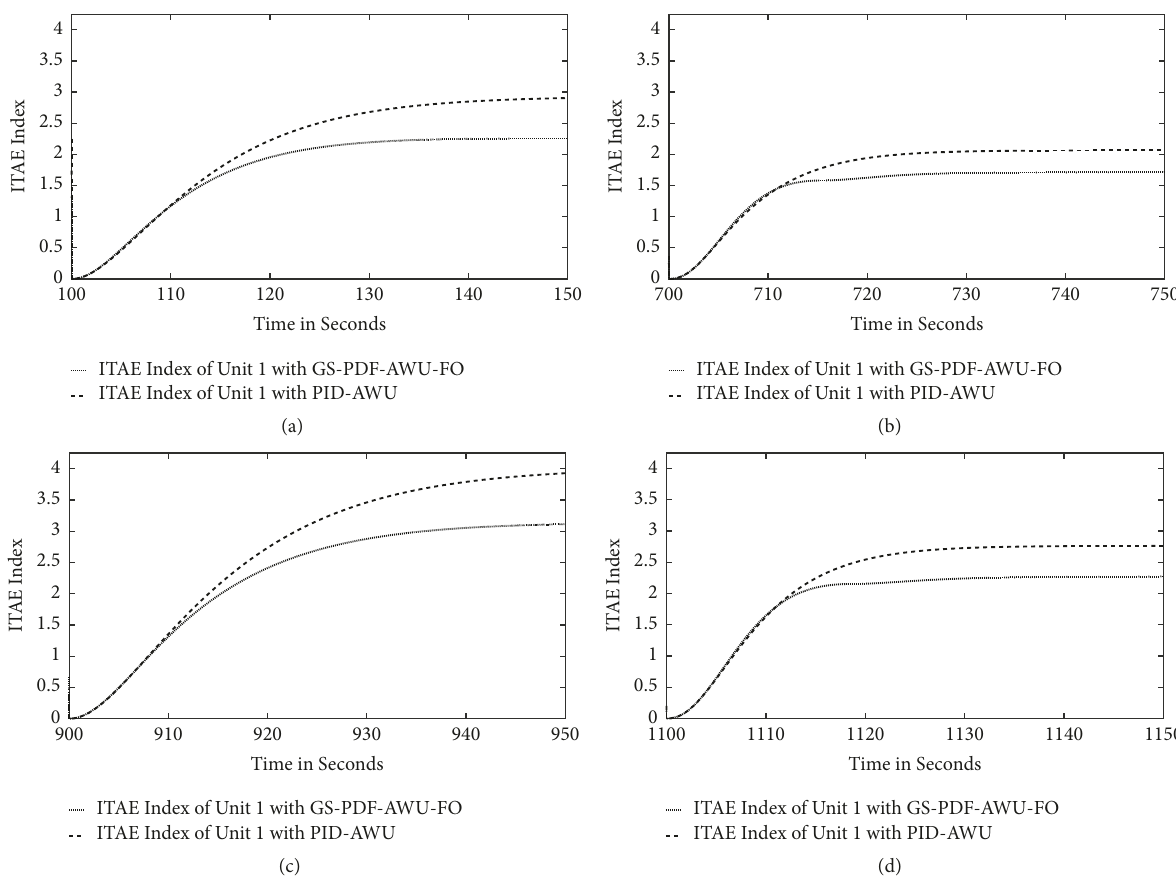
Figure 15: ITAE indexes. (a) One operational unit, h=1. (b) Six operational units, h=1. (c) One operational unit, h=0.9. (d) Six operational units, h=0.9.